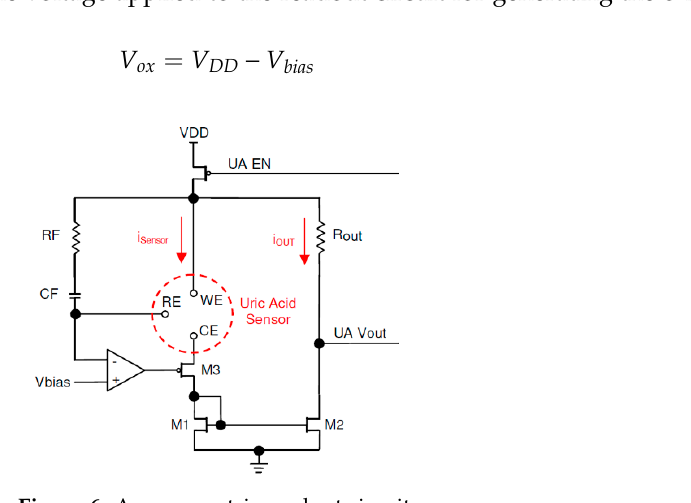
Figure 6. Amperometric readout circuit.